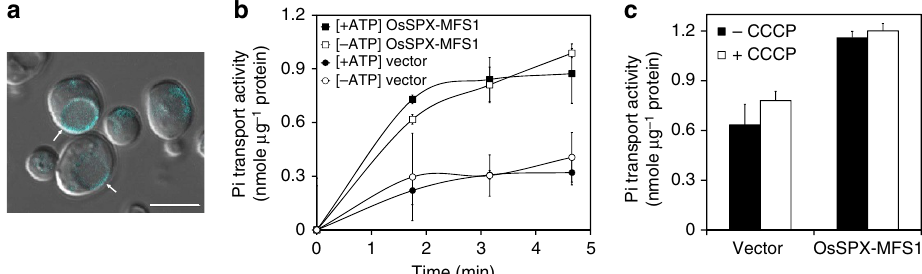
Figure 5 | Phosphate transport activity of rice OsSPX-MFS1 in isolated yeast vacuoles. ( a ) Fluorescence signal of yeast vtc4 mutant transformed with OsSPX-MFS1-ECFP . Arrows indicate the appearance of fluorescence signals in the tonoplast of yeast. Scale bar, 5 m m. 33 Pi uptake activity of vacuoles isolated from yeast vtc4 mutants transformed with empty vector (pAG415GPD) or expressing OsSPX-MFS1 in the presence of 4mM ATP [ þ ATP] or the absence of ATP [-ATP] at different time points ( b ) or in the presence of 10 m M carbonyl cyanide m-chlorophenyl hydrazone (CCCP) [ þ CCCP] or the absence of CCCP [ (cid:2) CCCP] at 285s post incubation ( c ). Error bar, s.e. ( n ¼ 3). Results were reproducible in two to four independent experiments.